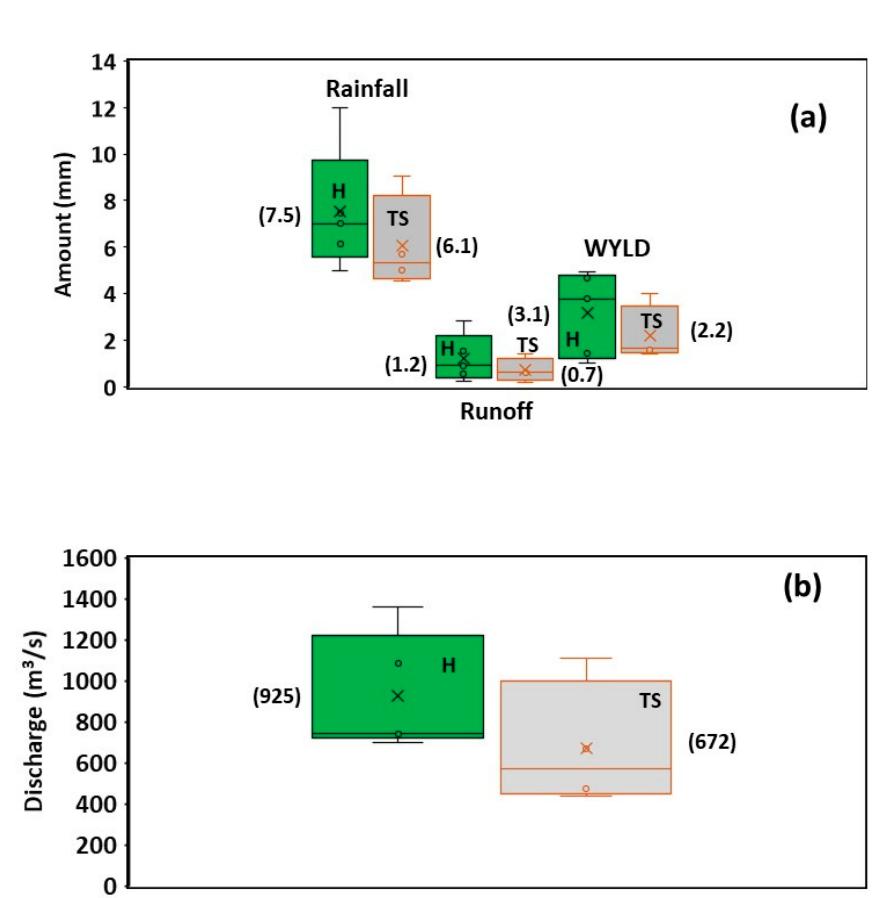
Figure 6. Comparison of ( a ) average daily rainfall, surface runoff and water yield (WYLD) and ( b ) stream discharge between the hurricanes (H) and the tropical storms (TS). The numbers in parentheses are the average values. Table 2. Component loading coefficients from principal component analysis. PC denotes principal